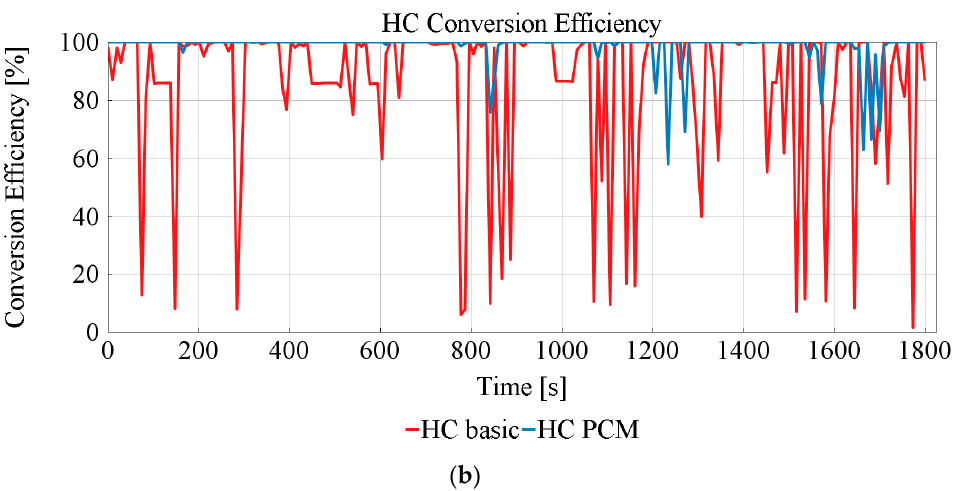
Figure 12. PCM effect on the TWC performance: ( a ) CO conversion efficiency; ( b ) HC conversion efficiency.